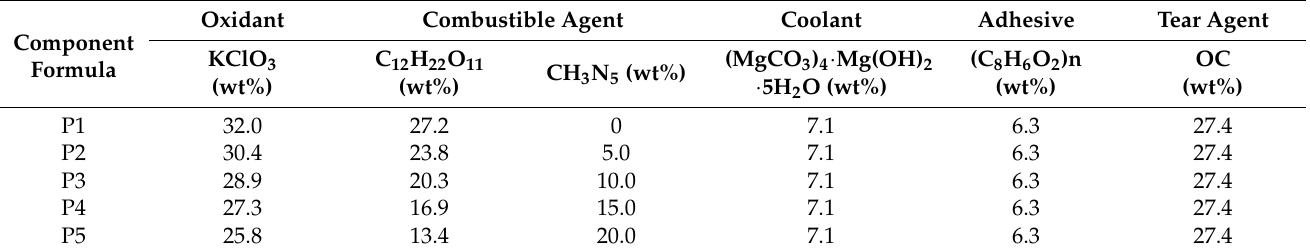
Table 1. Formula of the mixed agents at OB = − 0.18 based on a uniform design method.